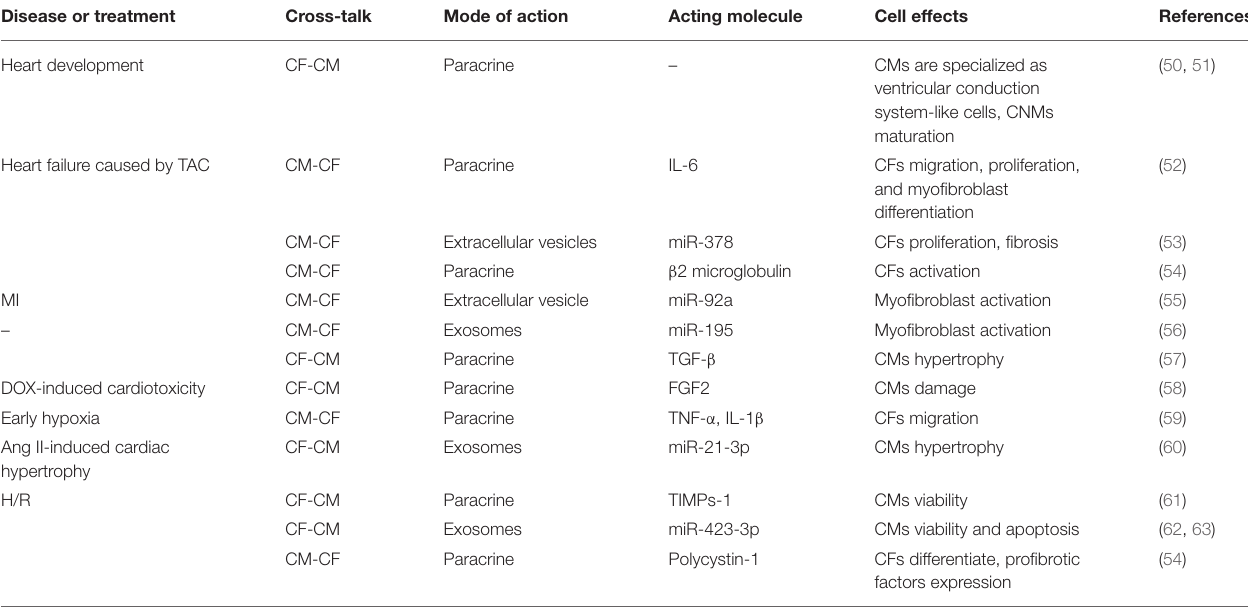
TABLE 1 | Table of CF-CM and CM-CF interactions in the cardiovascular field.